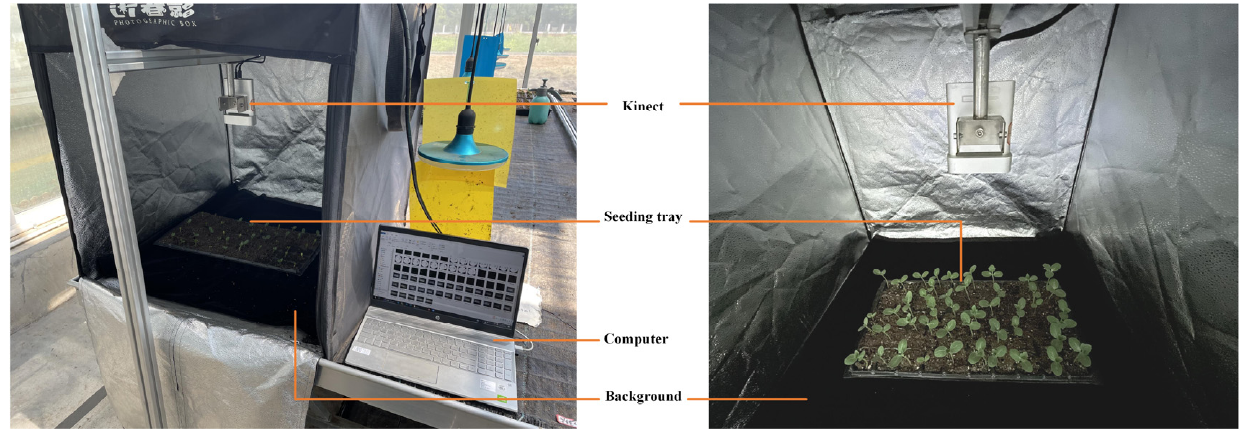
Figure 1. Plug seeding image data acquisition platform.